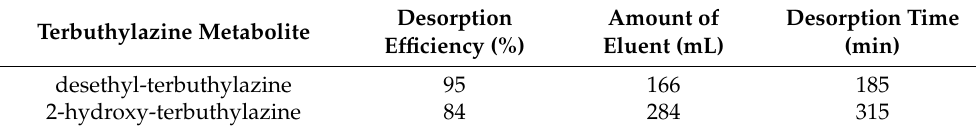
Table 8. Characteristics of terbuthylazine metabolites desorption